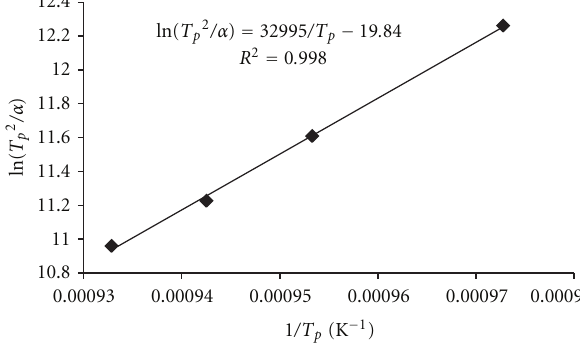
Figure 7: DTA scans at di ff erent heating rates of the selected glass: (a) 5 ◦ C · min − 1 ; (b) 10 ◦ C · min − 1 ; (c) 15 ◦ C · min − 1 ; (d) 20 ◦ C · min − 1 .